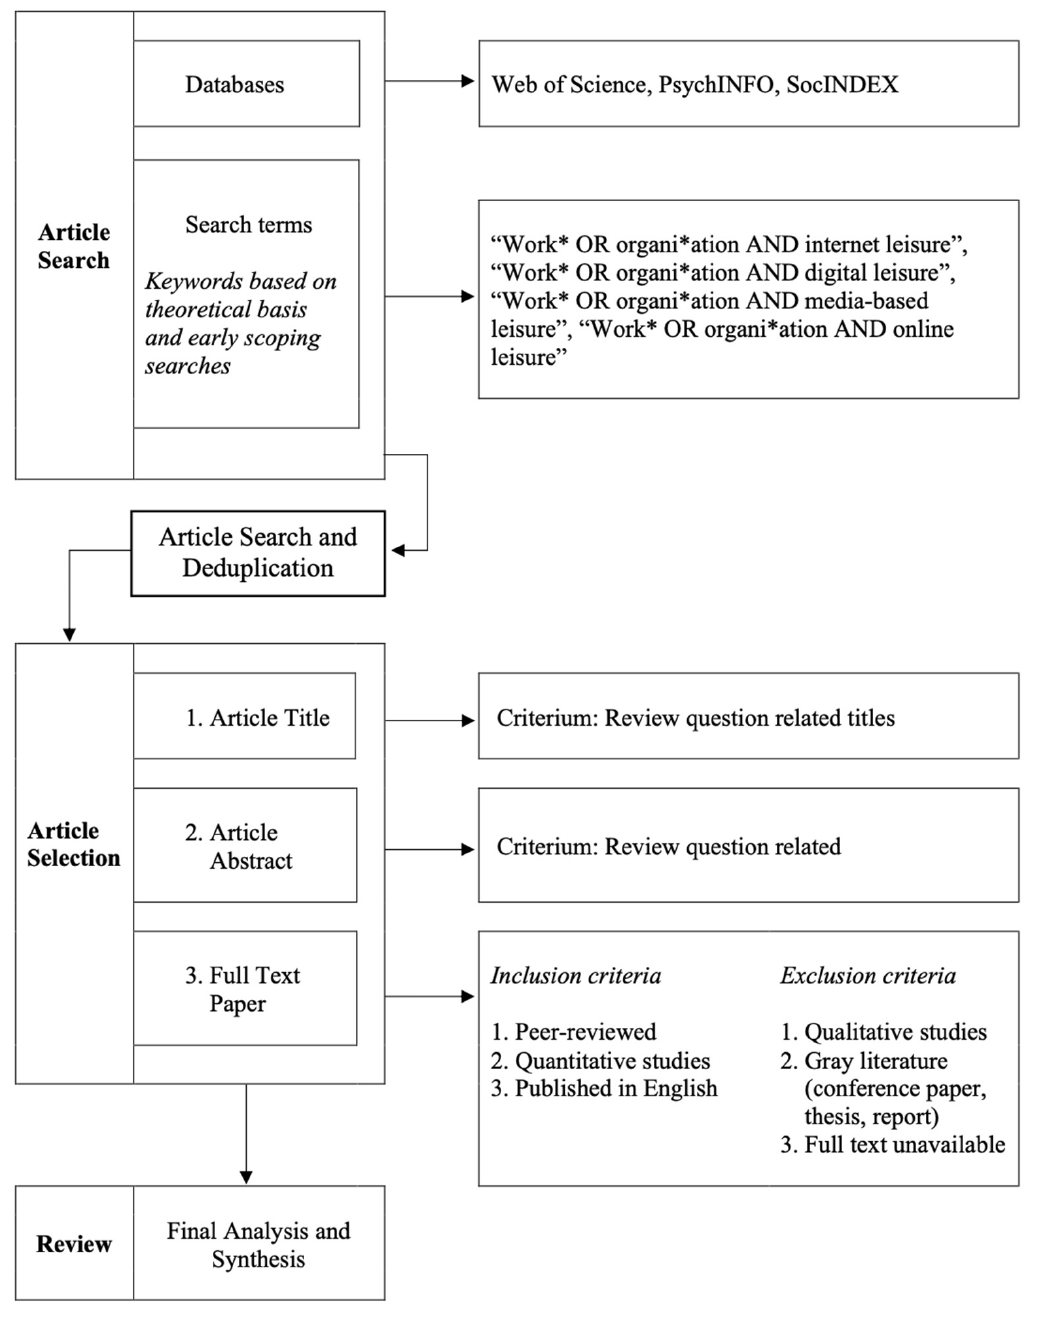
Figure 1. Overview of article search, article screening and the article selection process .